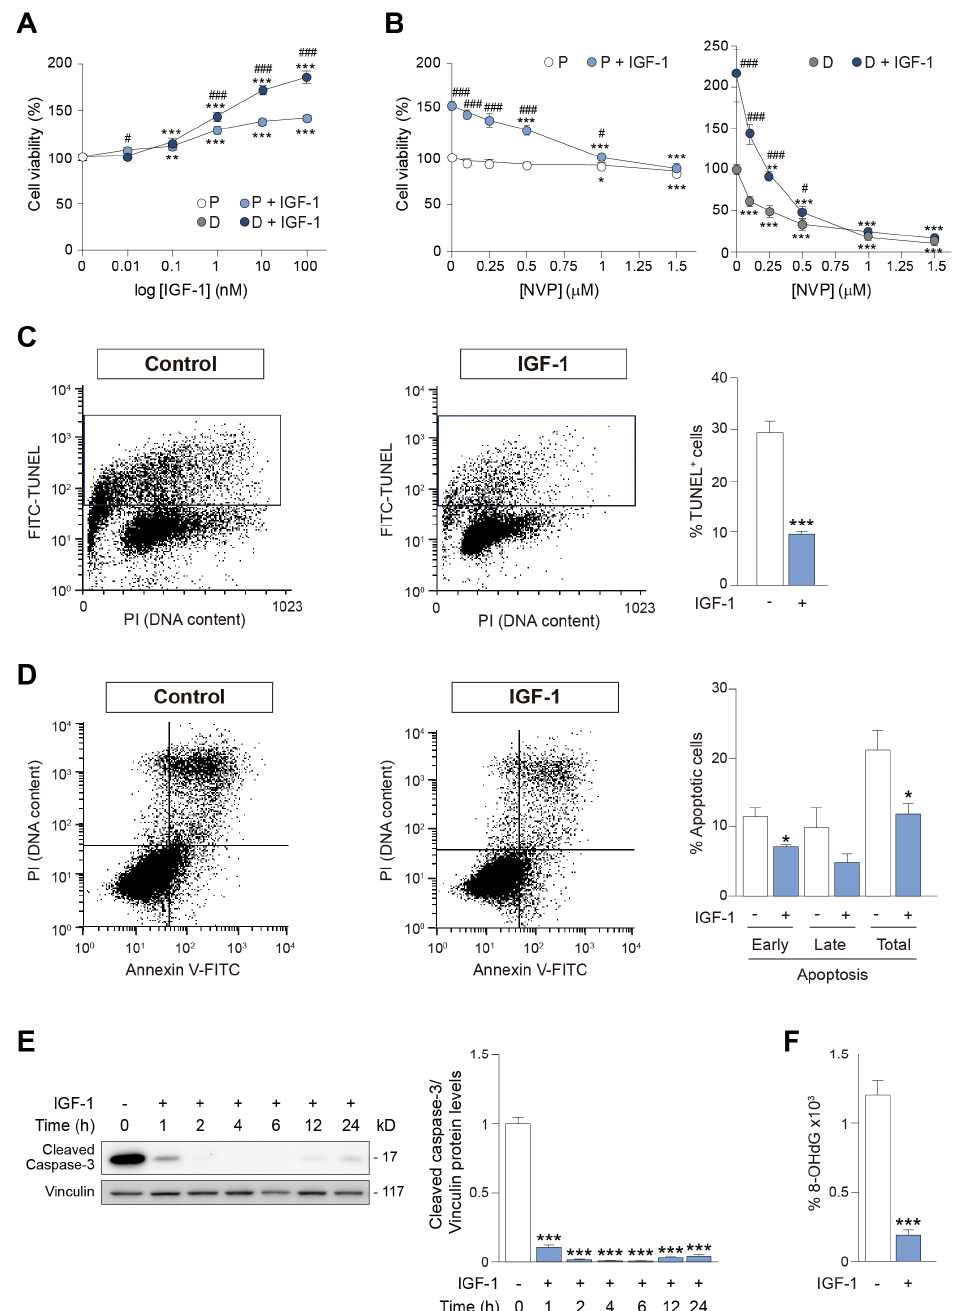
Figure 5. IGF − 1 enhances cell survival through IGF1R and inhibits apoptosis and DNA oxidative damage in HEI − OC1 auditory cells. ( A ) HEI − OC1 P (white circles) and HEI − OC1 D (gray circles) cells were cultured in control medium for 24 h and then treated with different concentrations of IGF − 1 (P, light blue circles; D, dark blue circles) for a further 24 h. Cell viability was measured by XTT assay. Average optical density measured in untreated control cells was taken as 100% of viability. Results are expressed as mean ± SEM from n = 2 independent experiments, with at least 5 independent samples per condition in each experiment. Statistical significance was estimated by Student’s t − test (### p < 0.001 versus HEI − OC1 P within same IGF − 1 dose) or by one − way ANOVA (** p < 0.01 and *** p < 0.001 versus untreated control cells) when there were two or more than two experimental groups, respectively. ( B ) HEI − OC1 P (left panel) or HEI − OC1 D (right panel) cells were cultured as above, treated with the IGF1R inhibitor NVP at different concentrations for 2 h, and then treated (P, light blue circles; D, dark blue circles) or not (P, white circles; D, gray circles) with IGF − 1 (10 nM) for 24 h. Cell viability was determined by XTT assay. Average optical density measured in untreated control cells was taken as 100% of viability. Results are expressed as mean ± SEM from n